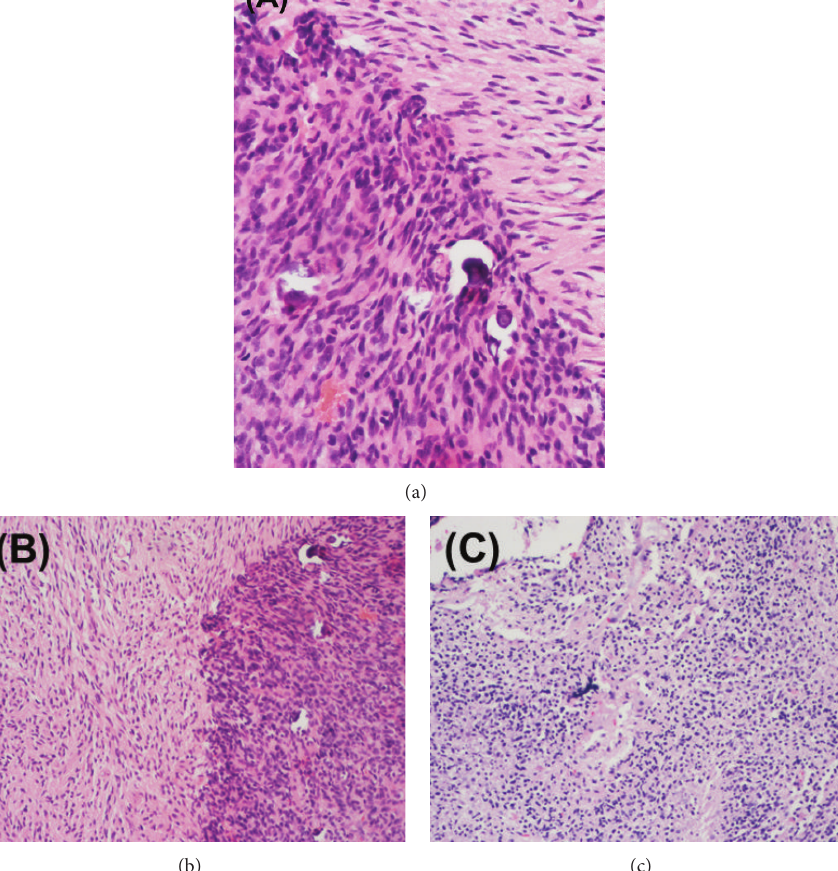
Figure 1: Surgical pathological specimens from (a) initial craniotomy and (b-c) repeat craniotomy for recurrent intracranial disease. Histopathological analysis of the initial (a) right temporal lobe specimen demonstrated glioblastoma with small cell features. The pathological specimen after second resection (b) demonstrated active glioblastoma, almost entirely viable with < 5% necrosis. Following the third and final (c) craniotomy for locally recurrent disease, predominantly viable (approximately 15% necrosis) active glioblastoma was identified. Molecular studies were negative for MGMT methylation and EGFR amplification was detected by